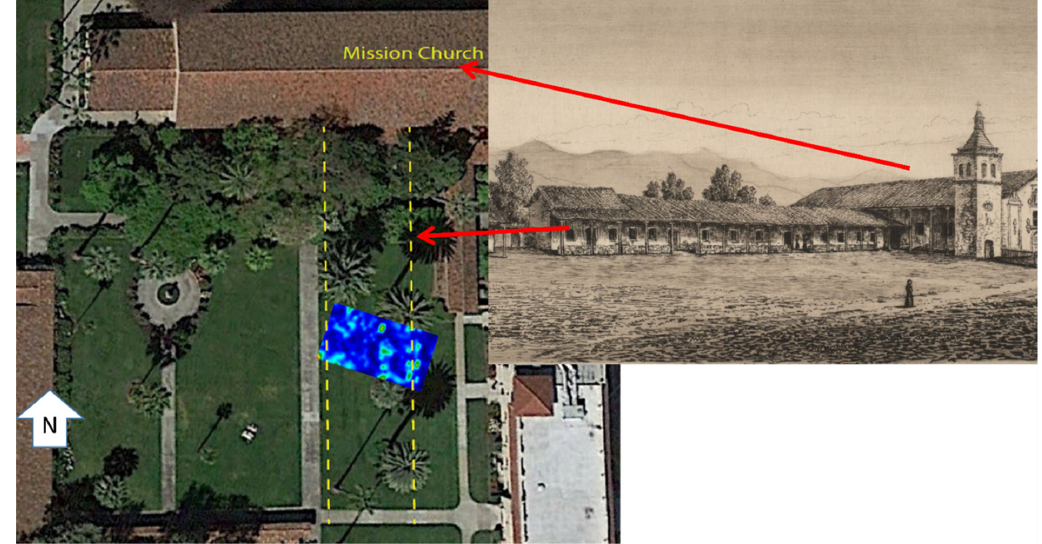
Figure 4. Mission Santa Clara on Santa Clara University campus, with the nearly perpendicular intersection of walls (yellow dashed lines) of the Mission Fathers’ residence (Grid 1).